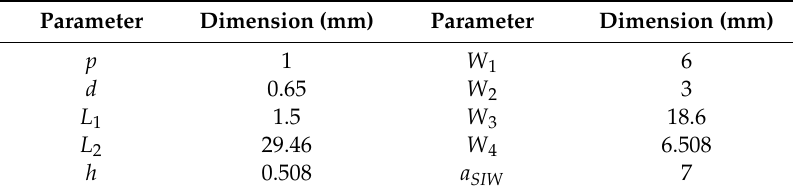
Figure 3. SIW variable phase shifter structure and parameters. Table 1. Dimensions of the SIW variable phase shifter.